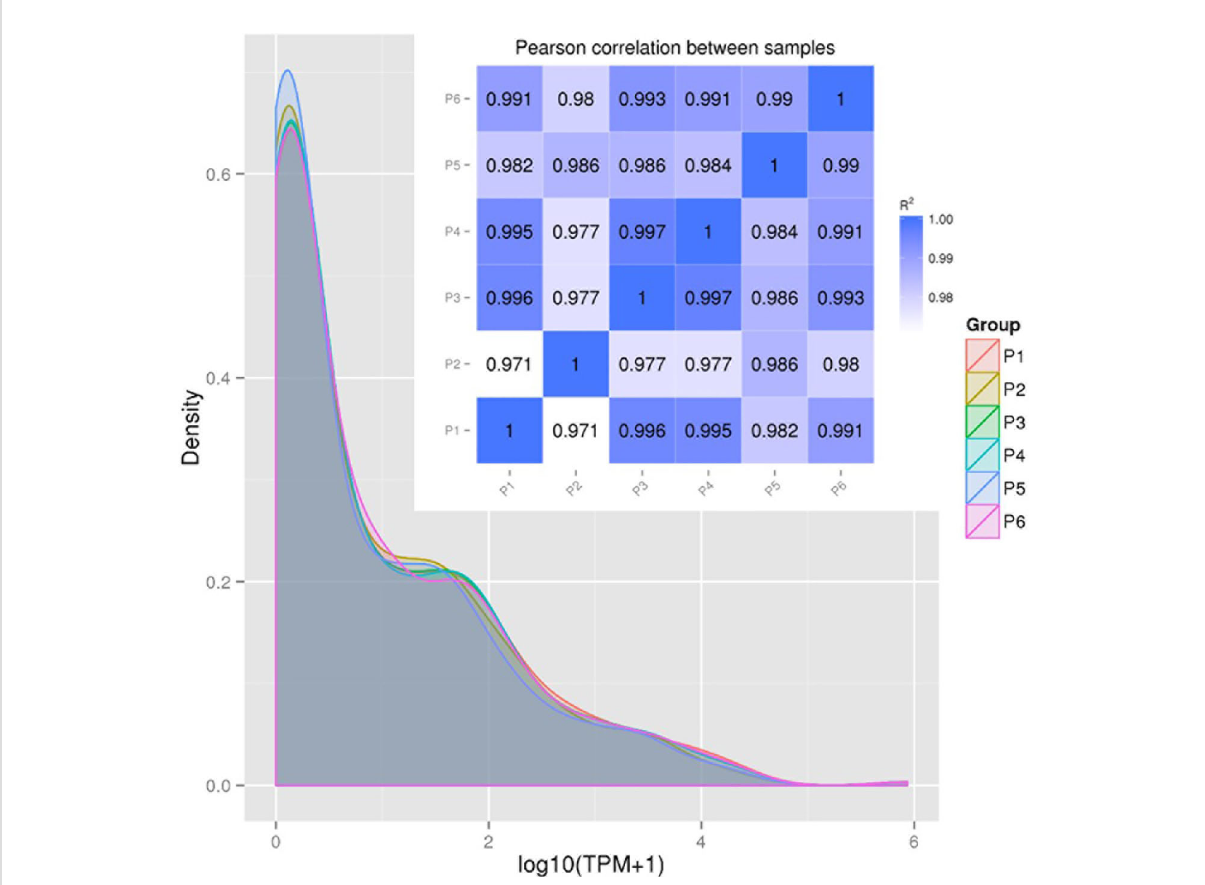
FIGURE 2 Correlation of miRNA expression levels between samples to show experimental repeatability for analysis of differential gene expression. miRNA expressions in each sample were statistically analyzed and normalized by transcripts per million reads (TPM). Shown are TPM density distribution patterns (shaded line chart) and Pearson Correlation (inset Pearson RSQ table) between samples. The closer the correlation coef fi cient is to 1, the higher the similarity between the samples. Encode suggests that the square of the Pearson correlation coef fi cient (R 2 or RSQ) should be larger than 0.92 under ideal experimental